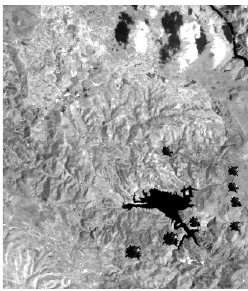
Figure 5: The band 4 of the the simulated Sardinia Dataset